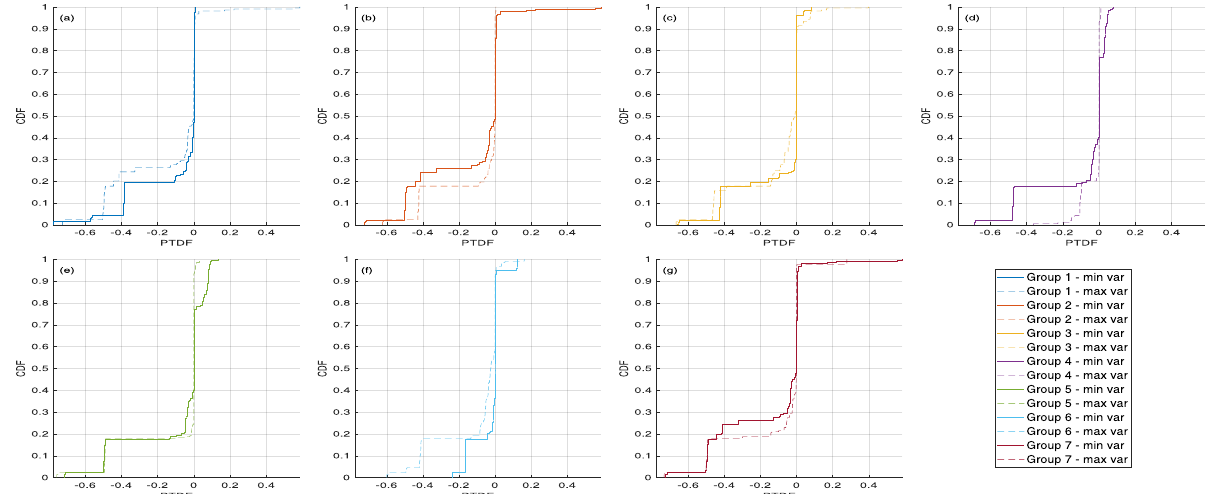
Figure 7. Cumulative Distribution Function (CDF) of the PTDF s computed for the two nodes with the highest and the lowest PTDF variance, for each one of the seven groups shown in Figure 5. In particular, subfigure ( a ) refers to group 1, PTDF s ∈ [−0.16, −0.136), subfigure ( b ) refers to group 2, PTDF s ∈ [−0.136, −0.112) , subfigure ( c ) refers to group 3, PTDF s ∈ [−0.112, −0.088), subfigure ( d ) refers to group 4, PTDF s ∈ [−0.088, −0.064) , subfigure ( e ) refers to group 5, PTDF s ∈ [−0.064, −0.04), subfigure ( f ) refers to group 6, PTDF s ∈ [−0.04, −0.016) , subfigure ( g ) refers to group 7, PTDF s ∈ [−0.016, 0.008].